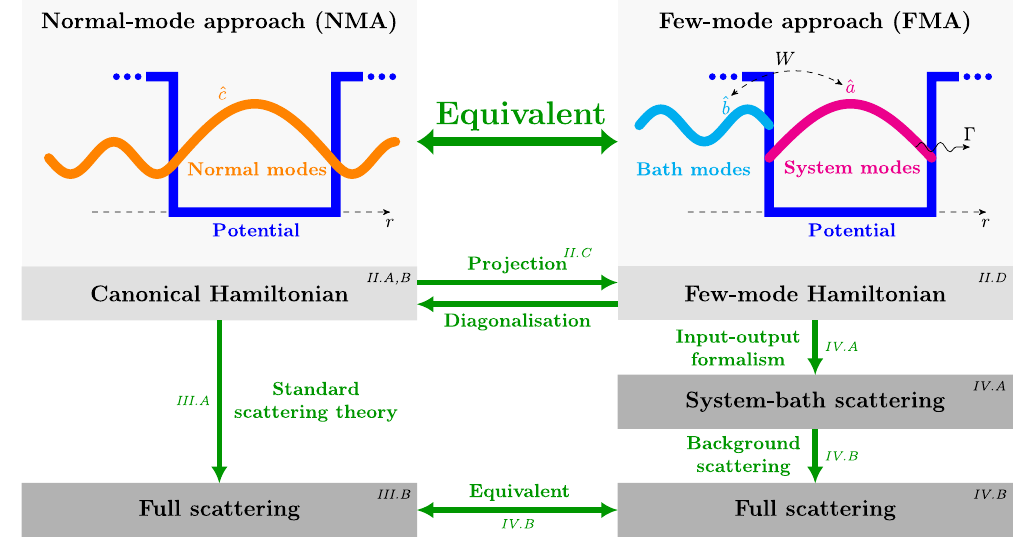
FIG. 1. Schematic of the theoretical connections on noninteracting theories presented in this paper. The left-hand side represents the NMA to quantum potential scattering, where one can rigorously obtain a Hamiltonian from canonical quantization. The latter is conveniently expressed in terms of normal-mode operators ˆ c (top left picture). The right-hand side represents the FMA, usually employed in terms of phenomenological models. There, a discrete set of system modes is coupled to a continuum of bath modes (top ˆ b , respectively, with coupling constant W and loss rate Γ . We show that the Hamiltonians right picture), corresponding to operators ˆ a and on each side can be connected by a basis transformation. A common method to calculate scattering observables in the FMA, known as the input-output formalism, can further be connected to standard scattering theory by the inclusion of a background scattering contribution. Having shown that the Hamiltonians as well as the methods for calculating scattering observables can be rigorously connected allows the normal-mode and the few-mode approach to quantized potential scattering theory to be regarded as